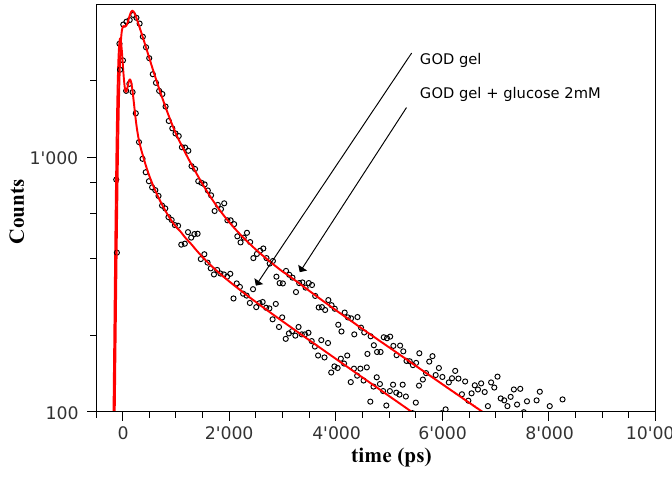
Figure 7. Black points are the fluorescence decays for immobilized GOD when excited = 405 nm) without and with glucose (2 mM). Red curves are in the FAD region ( (cid:21) exc three-exponential fits. The fitting parameters are reported in Table